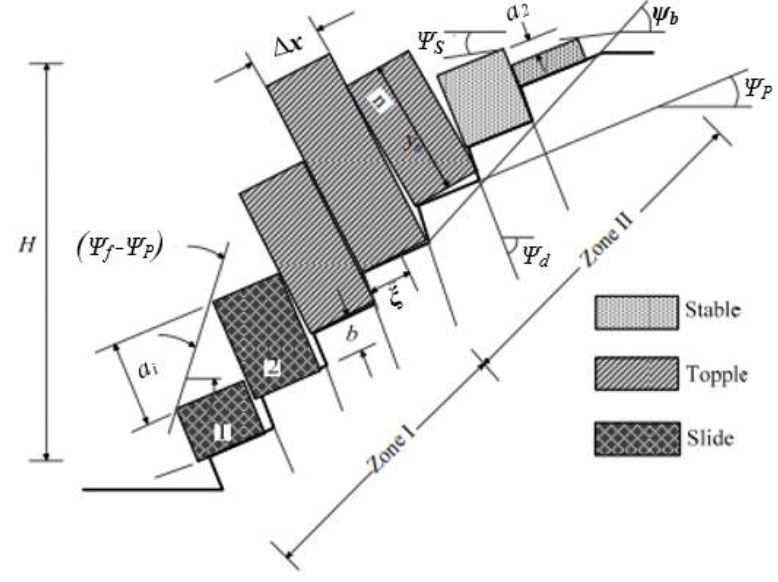
Figure 9. Geometry model of toppling slope failure (Adapted from [57]).